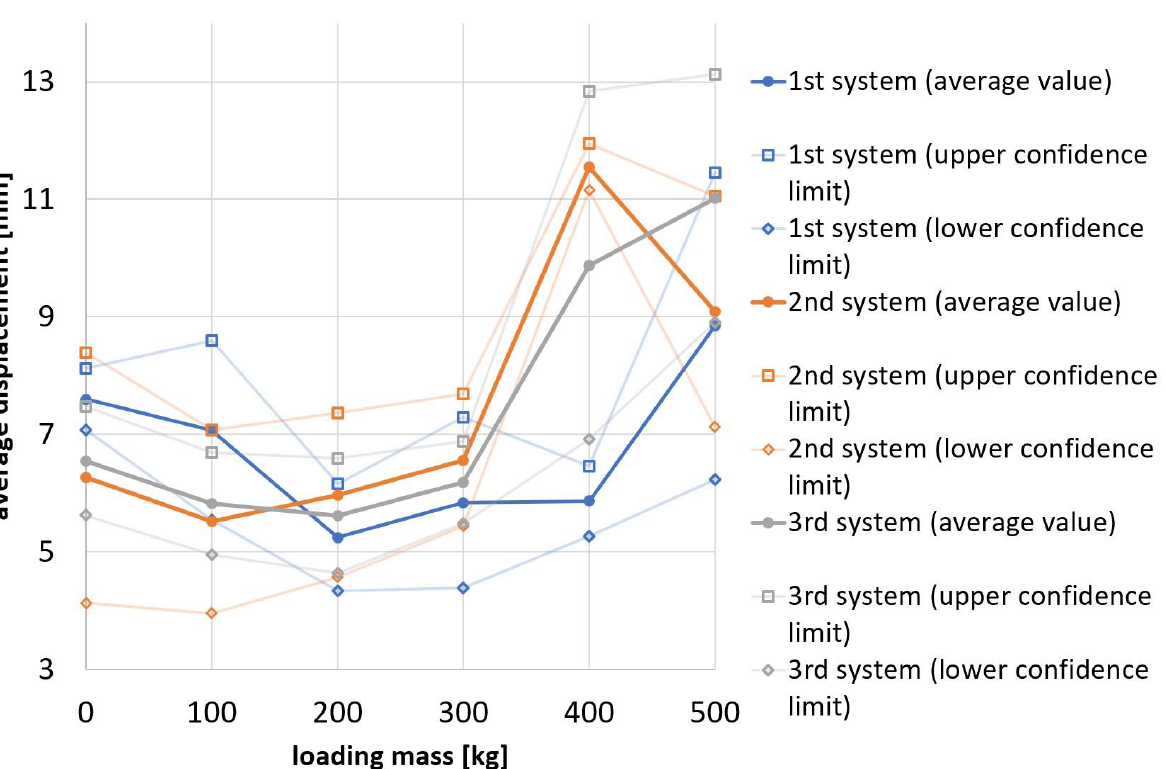
Figure 11. Confidence intervals with approximations, calculated for the confidence level of 95%, together with the average values of cylinder piston rod displacements recorded after the start of the stopping process, expressed as a function of the loading mass.